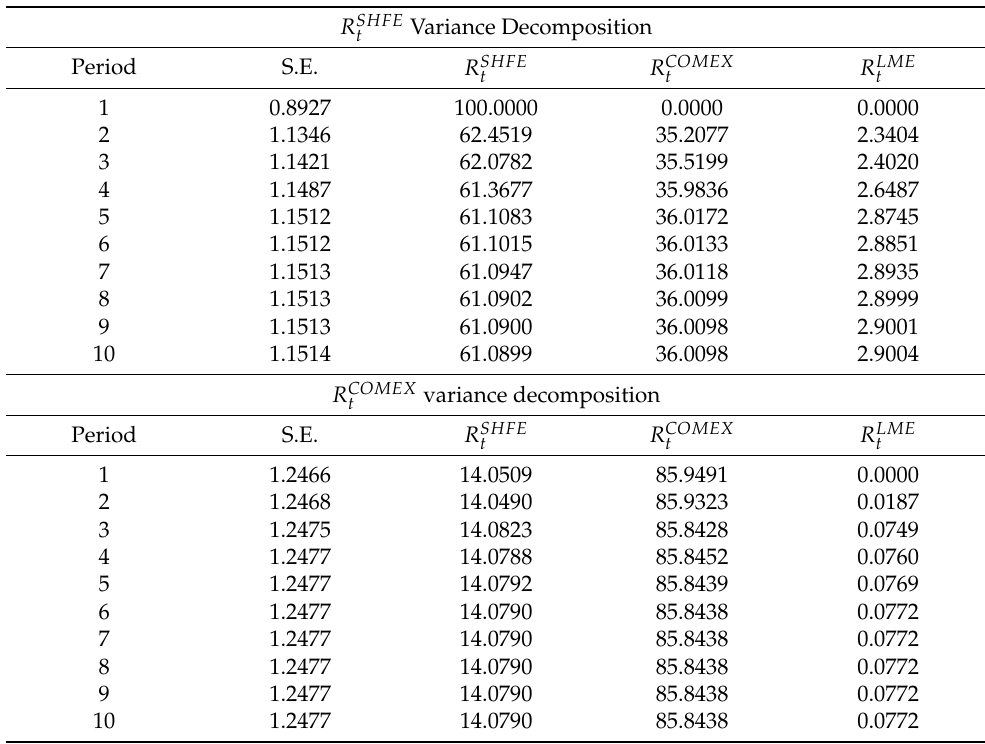
Table 7. Variance decomposition of copper returns in three markets in the second stage.